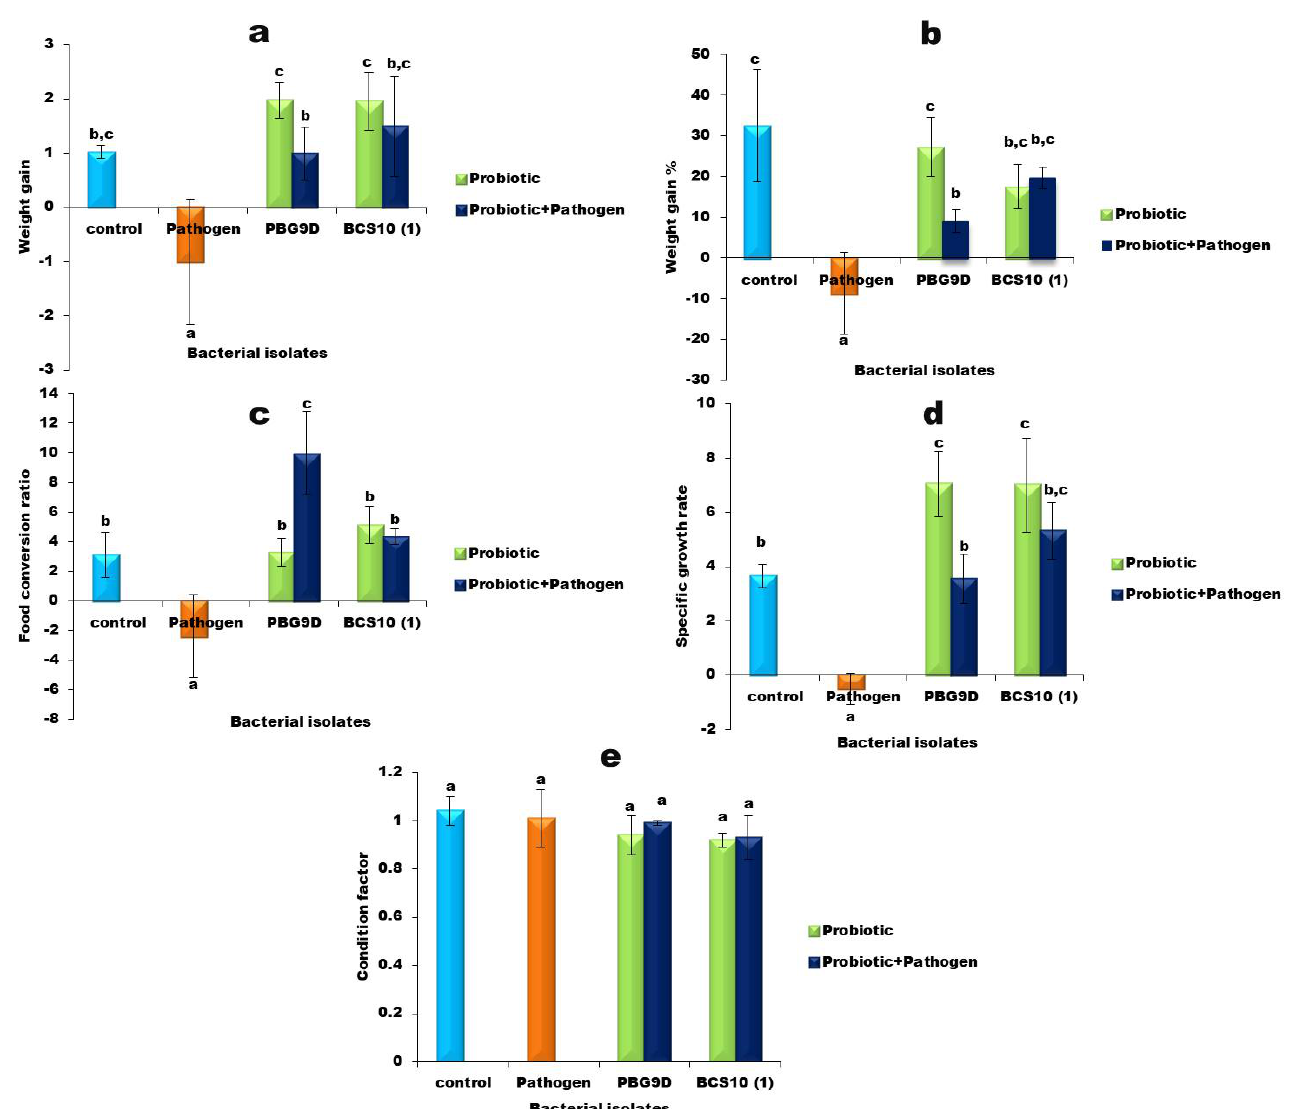
Figure 6. Growth parameters of Labeo rohita fed with basal and experimental diets for 28 days. ( a ) Weight gain, ( b ) weight gain %, ( c ) feed conversion ratio, ( d ) specific growth rate, ( e ) condition factor. Values represent mean ± SD. Different letters on bars indicate significant difference ( p ≤ 0.05) between groups (PBG9D and BCS10 (1)).